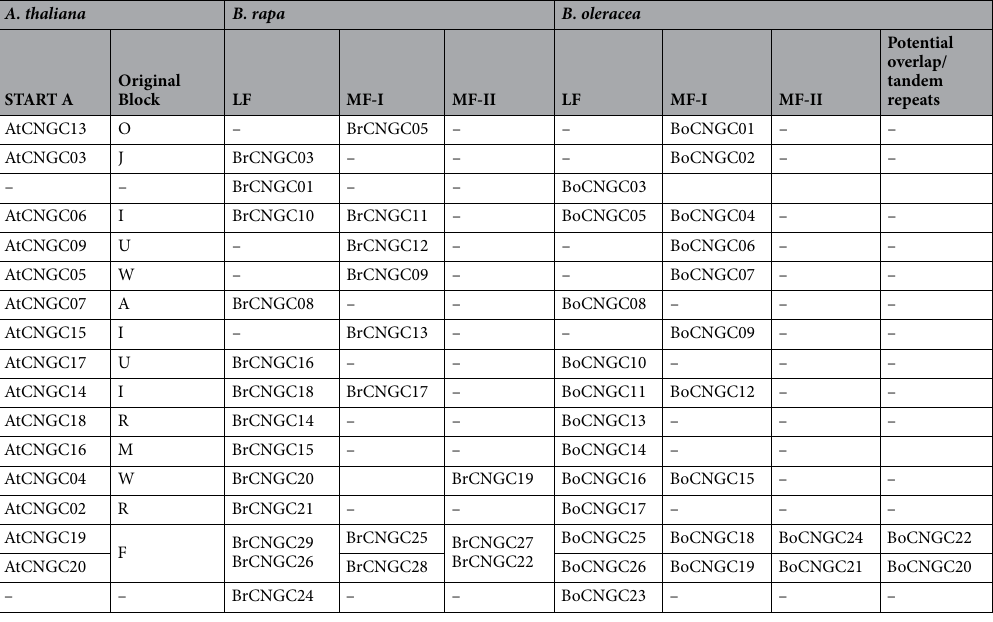
Table 2. Syntenic ancestral block structure between A. thaliana and three sub-genomes of B. oleracea and B. rapa